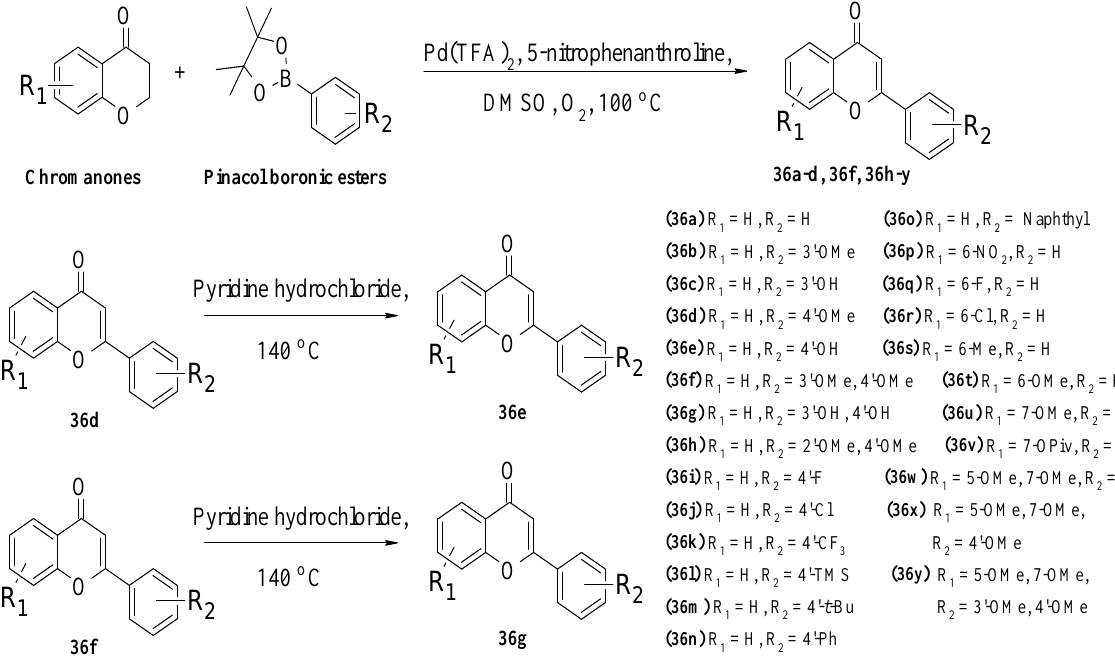
Figure 8. Synthesis pathway of new flavone derivatives and their chemical structures [38].